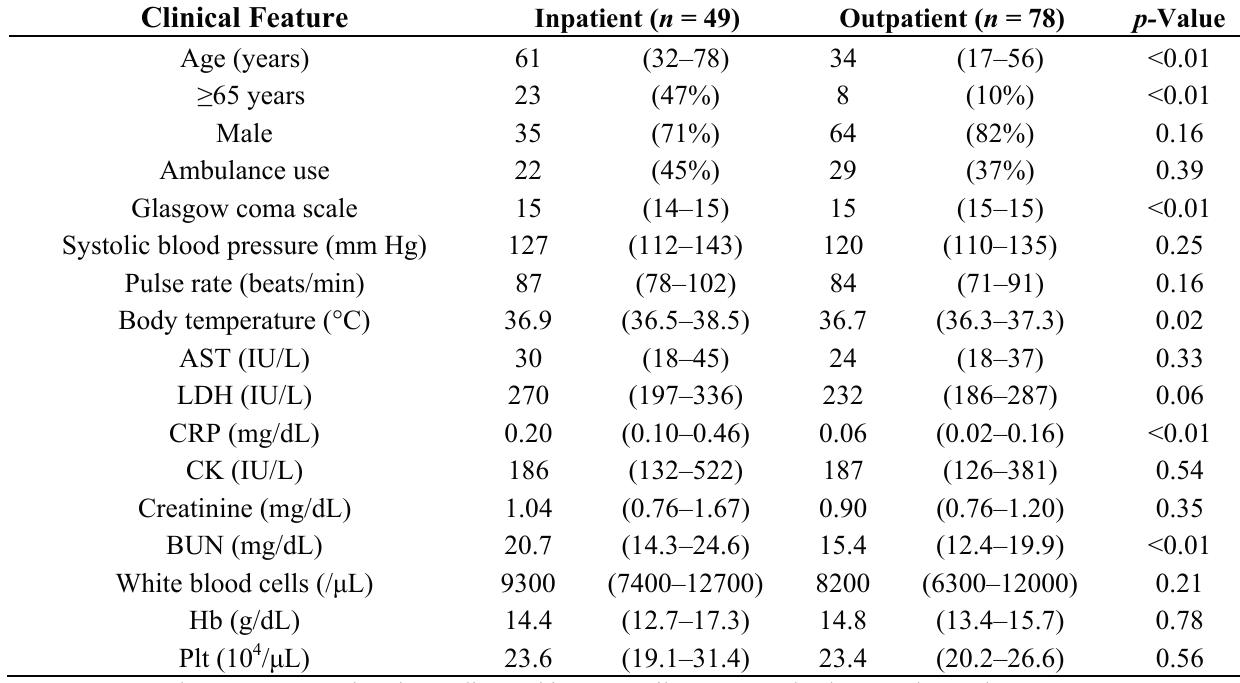
Table 1. Comparison of the clinical features between hospitalized and non-hospitalized patients with heat illness.